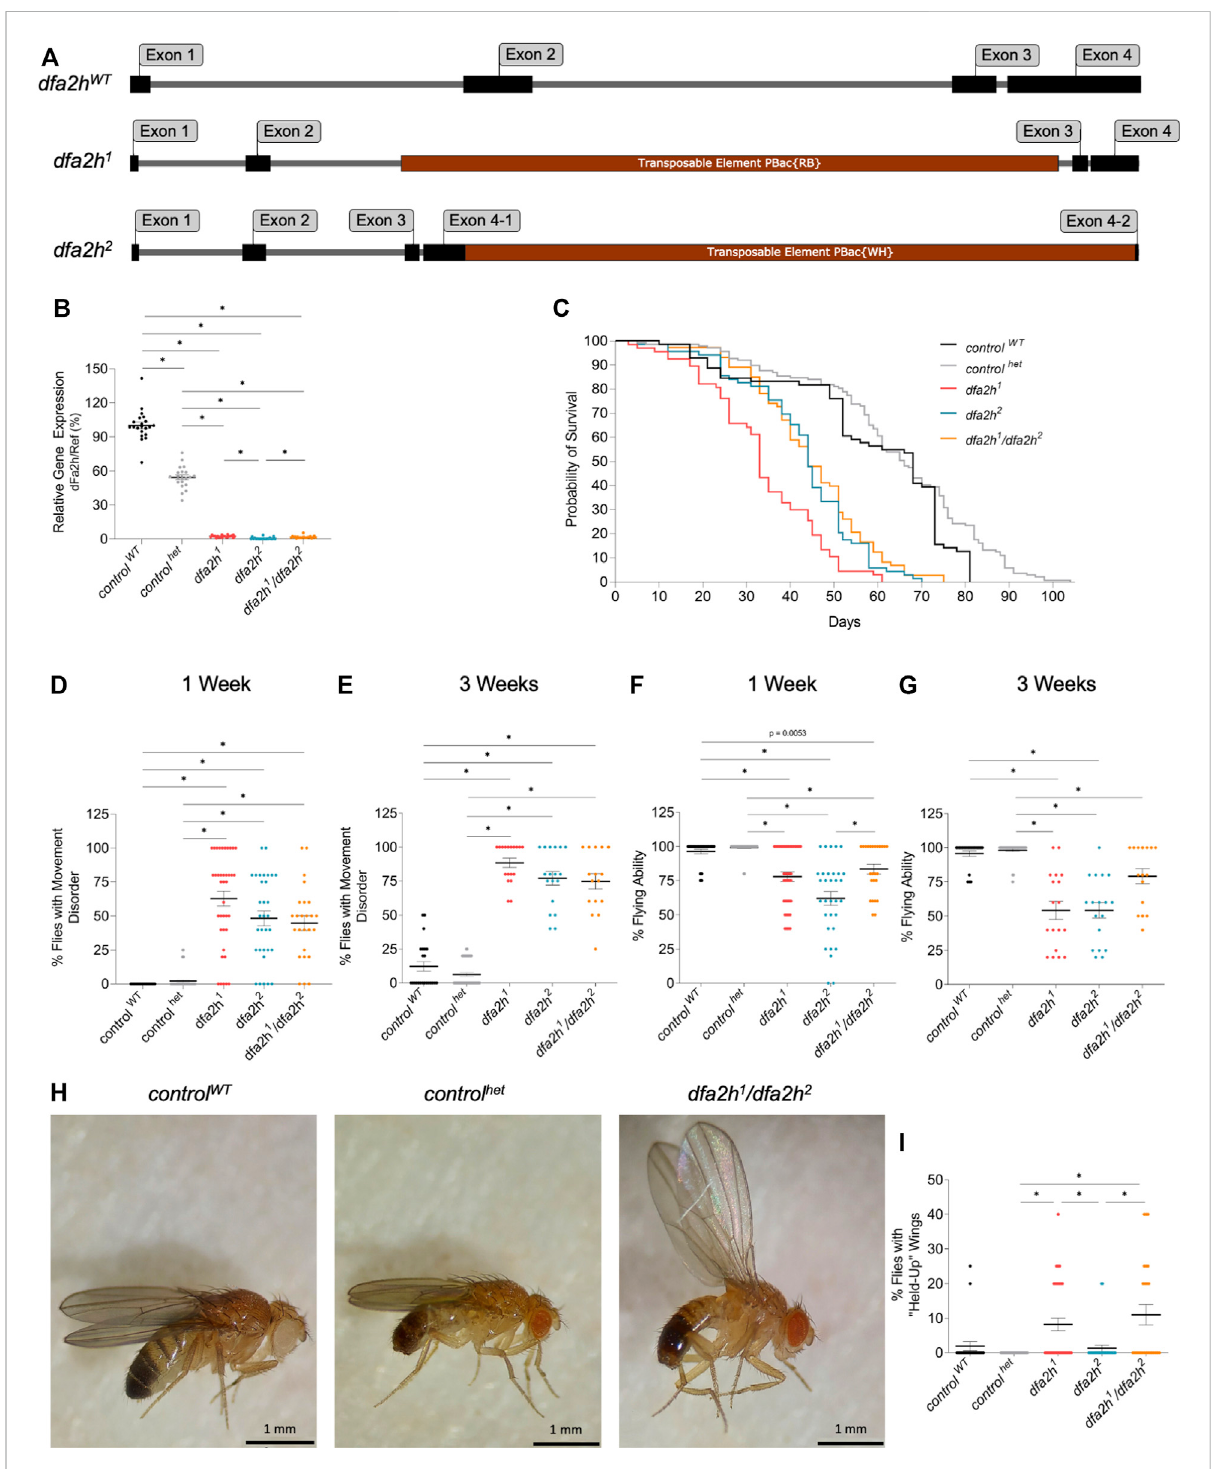
FIGURE 1 Transposableelement insertion leads to reduced dfa2h cDNAlevel,causing reduced lifespanand motordisabilities. (A) Schematic imageofthe gDNA of dfa2h WT and the transposable element insertion lines dfa2h 1 and dfa2h 2 . (B) Relative dfa2h level normalized to the combined data of the reference genes Act5c , Rpl32, and eEF1 α 2 expressed as percentages relative to control WT that was set to 100%. The dots represent the single data points,andthelinesshowmean±SEM(n=21). (C) Survivalmonitoringof dfa2h mutant fl ies, control het and control WT (n=67-137).Groupcurve comparisons were performed using log-Rank (Mantel-Cox) Test with a signi fi cance level of p < 0.05 (*). We performed a pairwise curve comparison